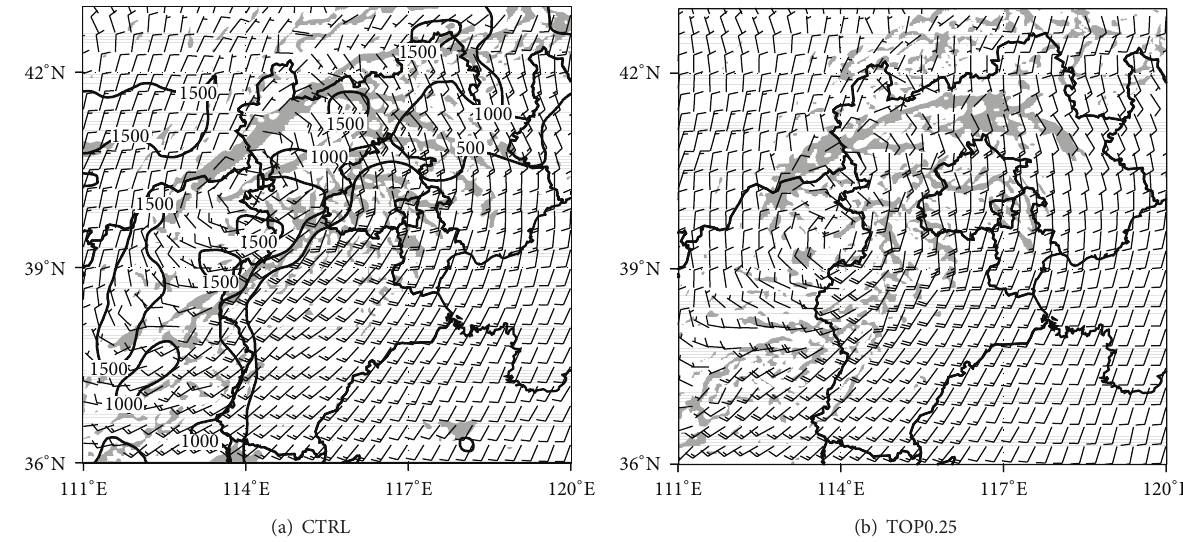
Figure 8: Simulated divergence (shaded, greater than 1 × 10 −4 s −1 ) with terrain height (contour) at 1800 UTC 21 July 2012 from (a) CTRL and (b)